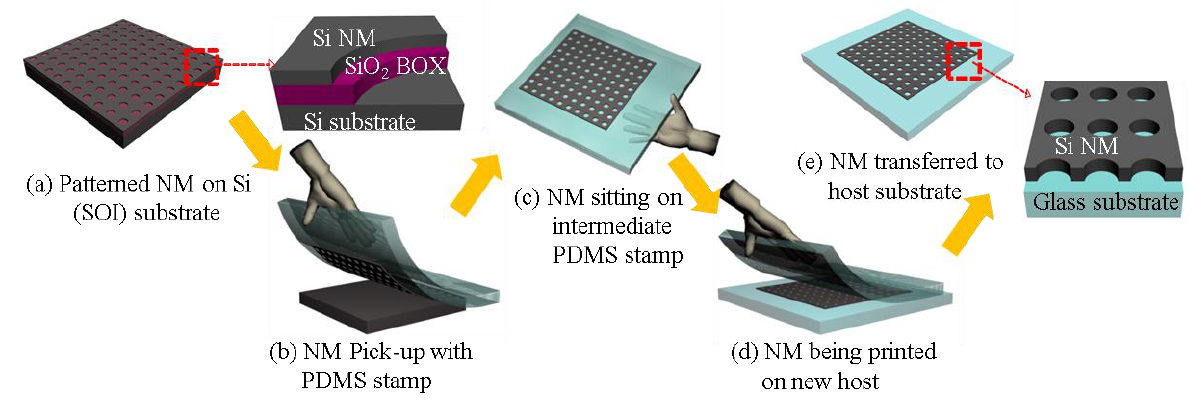
Figure 2. A NM printing process flow with a PDMS stamp. ( a ) Fabricated Si MR on a SOI substrate; ( b ) Top Si NM is released and picked up by a PDMS stamp; ( c ) Si NM is intermediately transferred on PDMS stamp; ( d ) Si NM is being printed on recipient (glass) substrate; and ( e ) Transferred SiNM on final glass substrate. Reproduced with permission from [37].